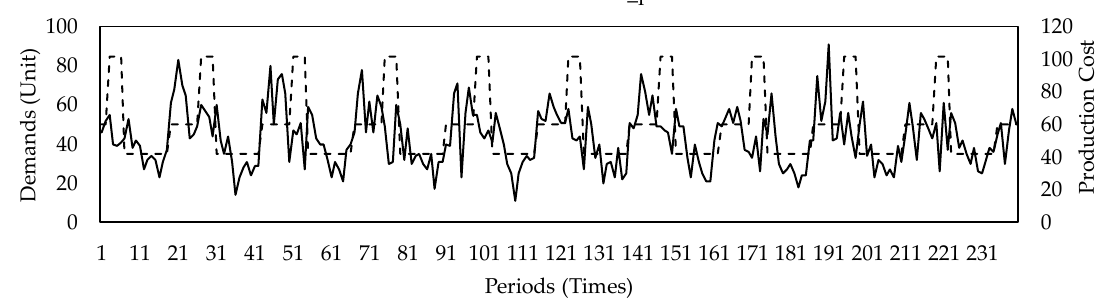
Figure 4. Sample operational history from the case study.